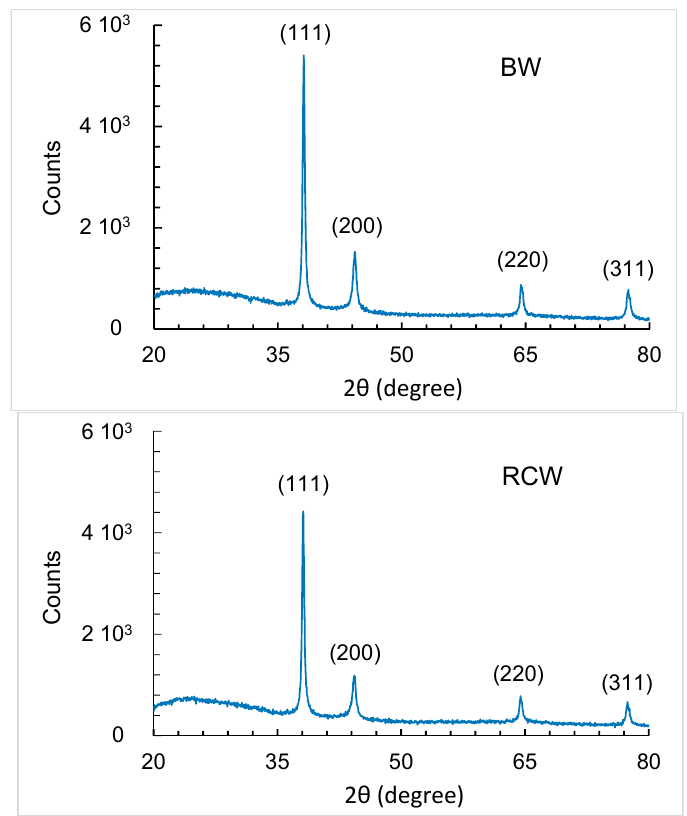
Figure 7. XRD patterns of Ag-NPs obtained from bilberry waste (BW) and red currant waste (RCW) extracts with the four peaks corresponding to metallic silver.